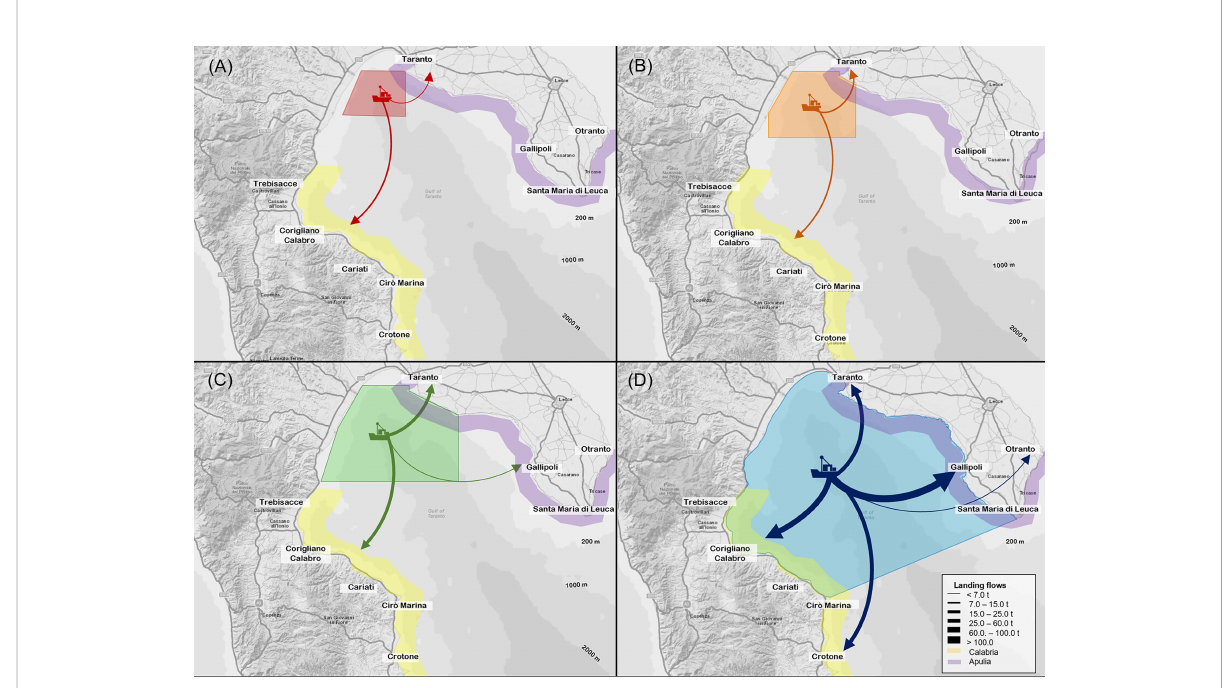
FIGURE 9 Landings fl ows (tons) from (A) the Red CCA, (B) Orange CCA, (C) Green CCA and (D) the Northern Ionian Sea towards the main fi shing harbours aggregated in the Calabrian (yellow) and Apulian region (violet). Thickness of arrows is proportional to the magnitude of fl